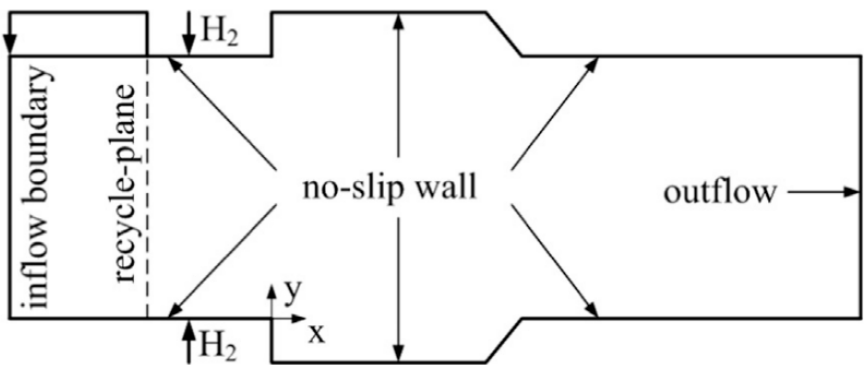
Figure 2. Schematic of the computational combustor [20].